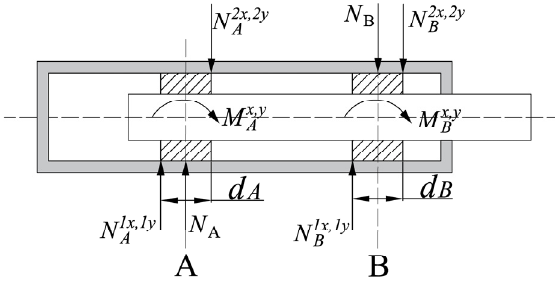
Figure 5. Schematic of reaction forces on upper and lower surfaces of bearings.